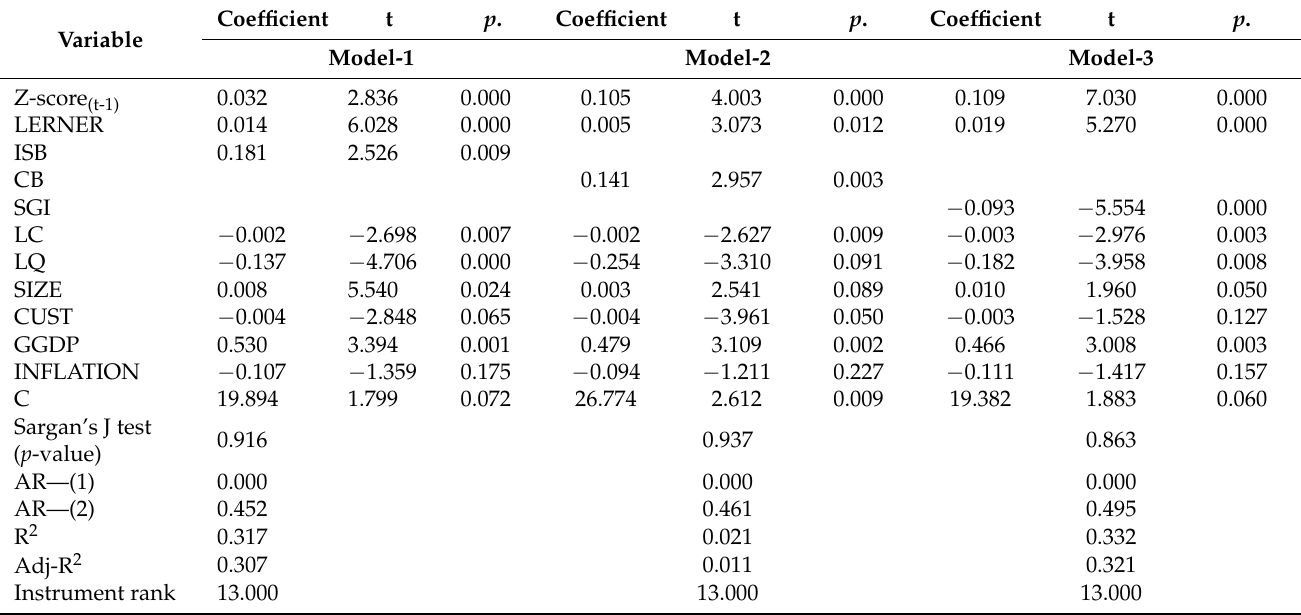
Table 8. Effects of competition (based on Lerner index), loan quality and ownership structure on financial